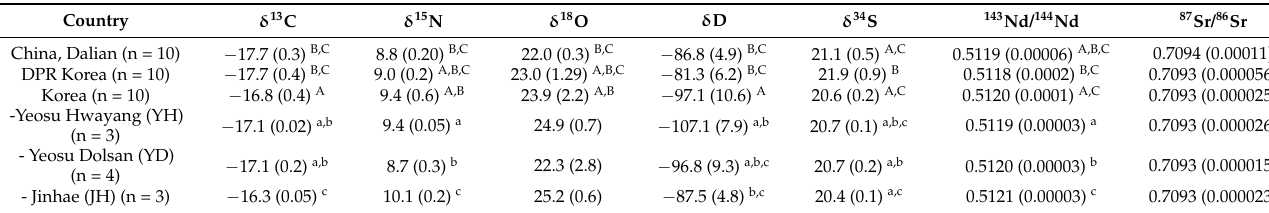
Table 1. Isotope values of the Manila clam Ruditapes philippinarum from China ( n = 10), DPR Korea ( n = 10), and Korea ( n = 10; three sites). Significant differences were analyzed by ANOVA ( p < 0.05; Tukey post hoc tests). Superscript letters indicate significant difference following ANOVA (capitals and small letters represent significant differences in three countries and three sites in Korea,